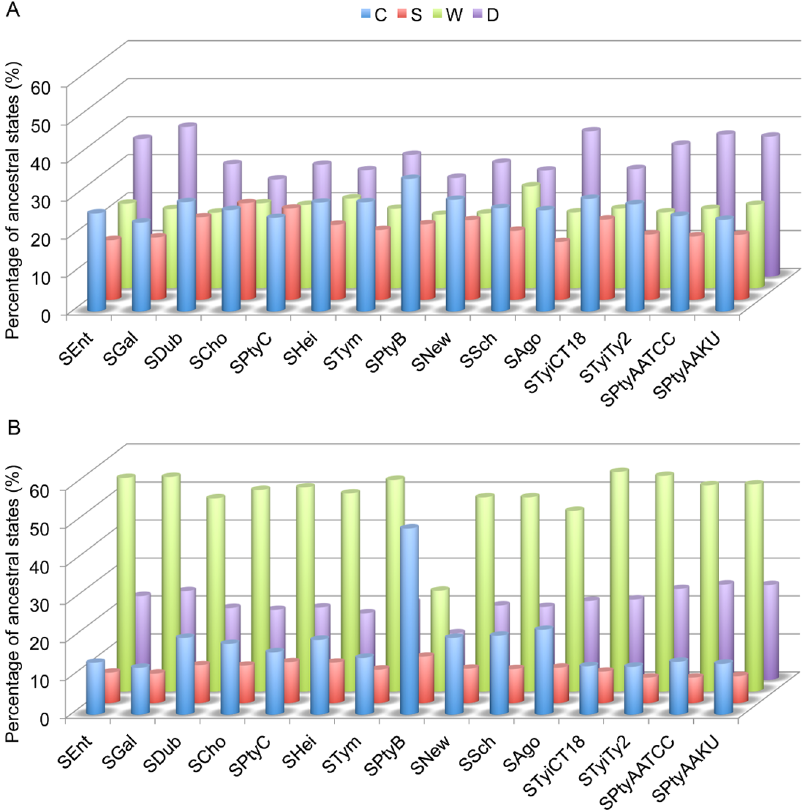
Figure 2. Fate of the genes in pan-Overlaps in Salmonella strains. (A) Average of the percentages of the genes inside operons. (B) Average of the percentages of the genes outside of operons.